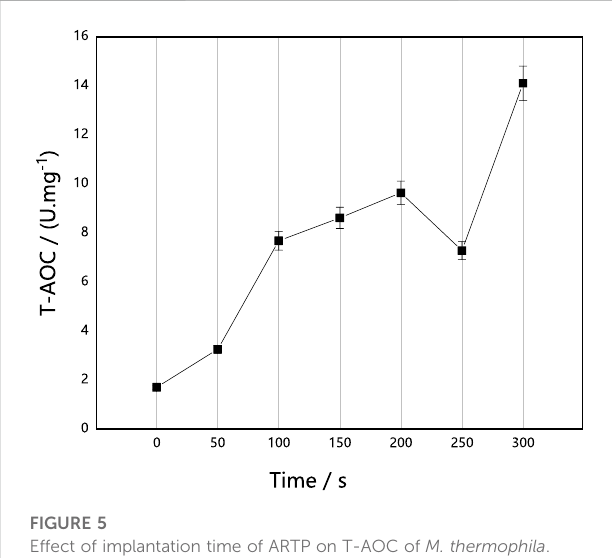
Effect of implantation time of ARTP on T-AOC of M. thermophila . T-AOC activity was determined according to the Fe 3+ reduction reaction. Reagents preparation and results determination were carried out according to kitrequirements. All experiments werecarriedout four times (biological duplicates and technical duplicates) and mean values presented with standard deviations.